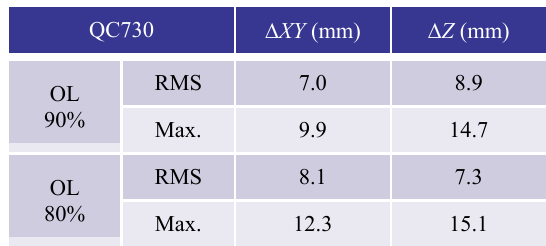
Table 5. Measurement errors of 9 check points by Phantom 4 vs. overlapping ratio